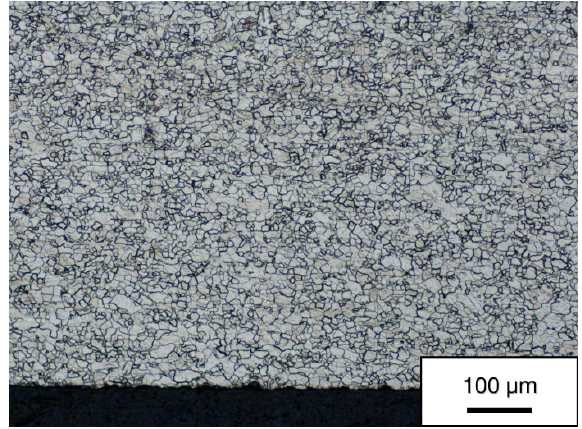
Figure 3. Microstructure in the as-received state in the transverse direction.